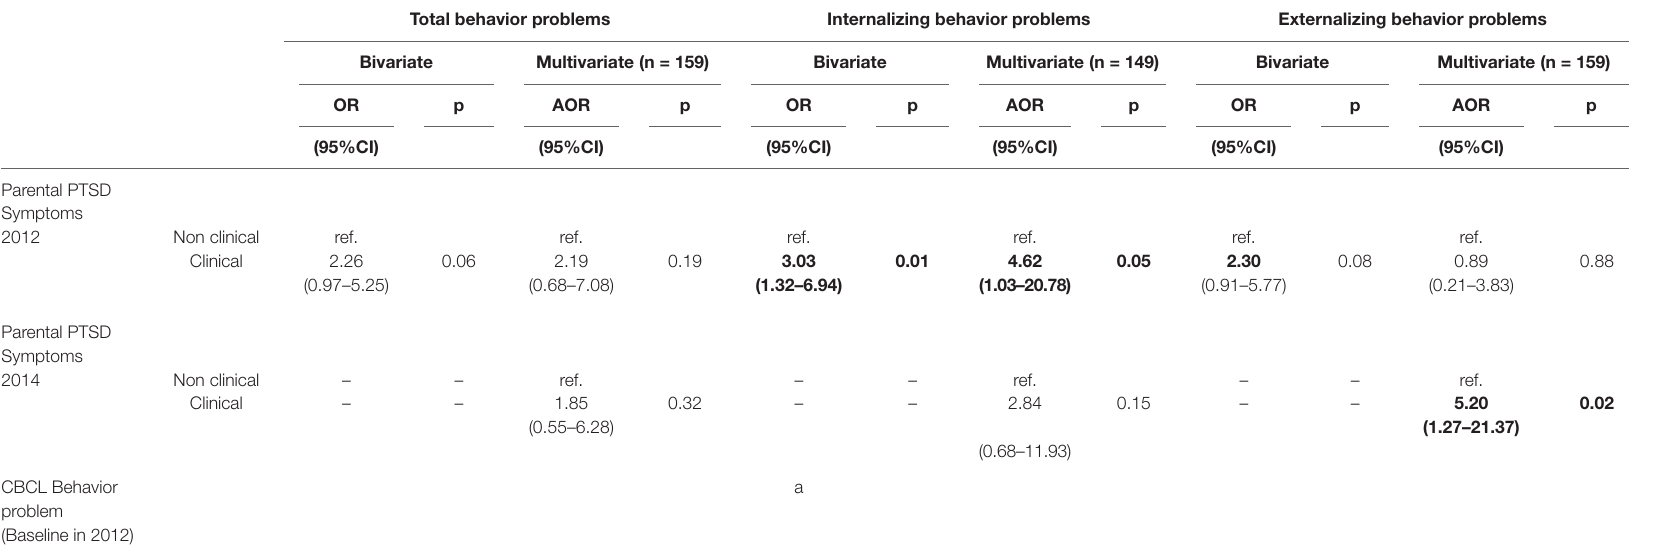
TABLE 5 | Association between parental PTSD symptoms in 2012 and children’s behavioral problem in